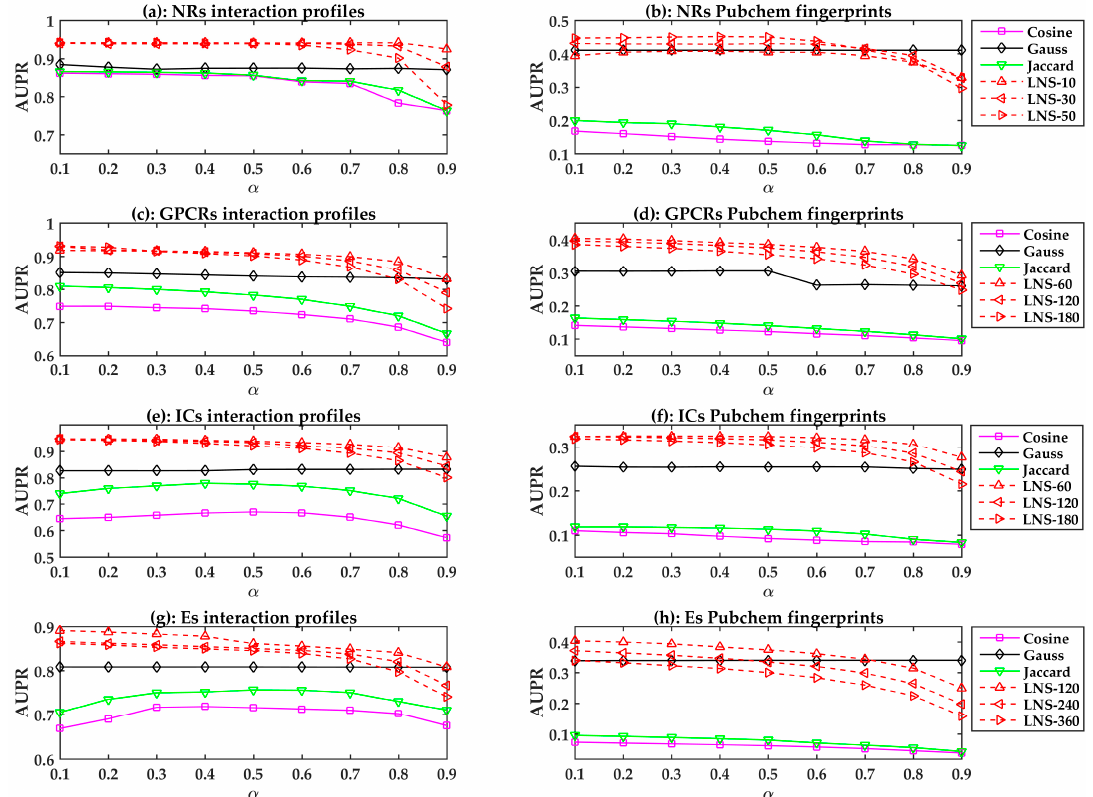
Figure 1. The area under the precision-recall curve (AUPR) values of the similarity-based models with different parameters. LNS-10 means LN similarity-based models constructed with 10 neighbors. Other symbols have the similar meanings.